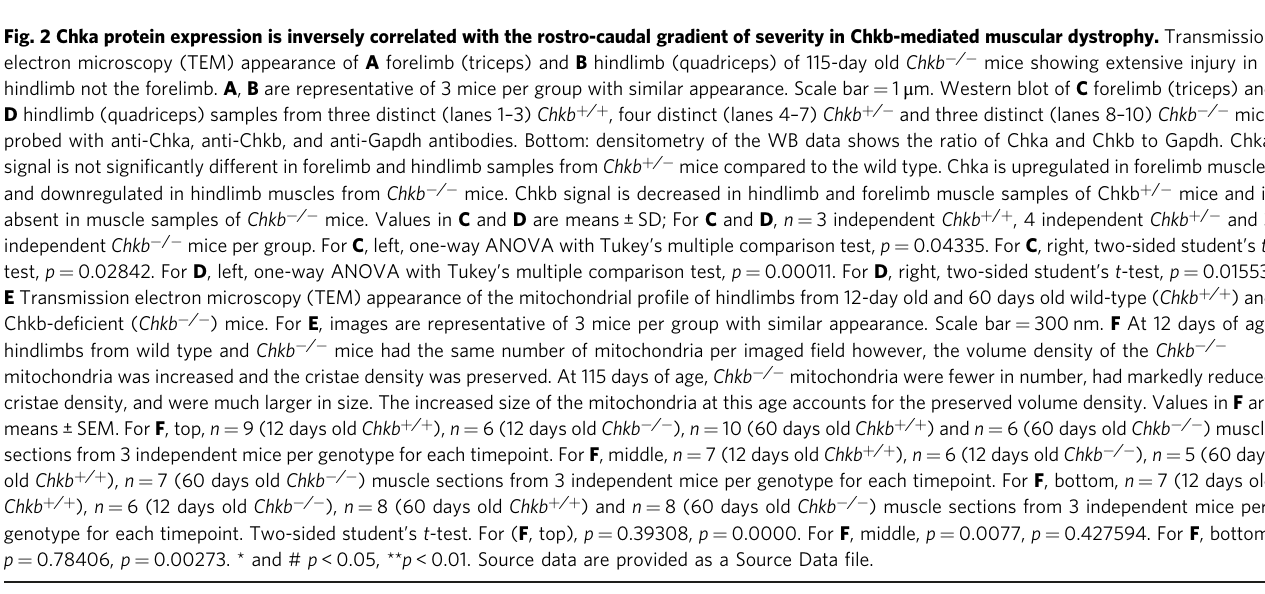
Fig. 2 Chka protein expression is inversely correlated with the rostro-caudal gradient of severity in Chkb-mediated muscular dystrophy.